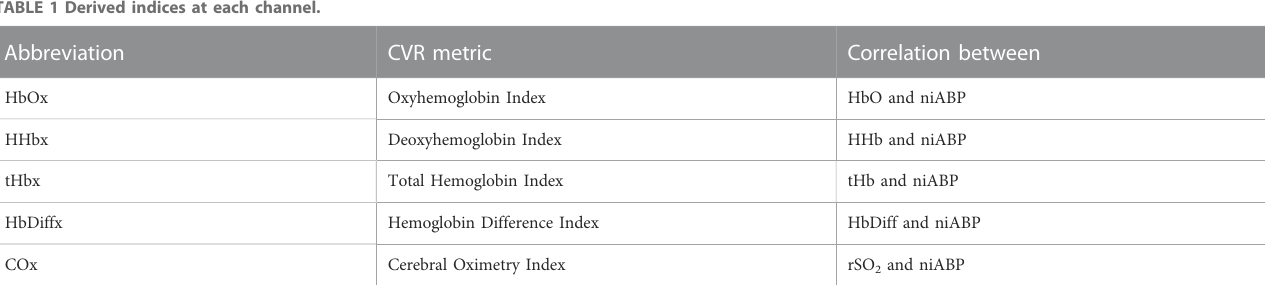
TABLE 1 Derived indices at each